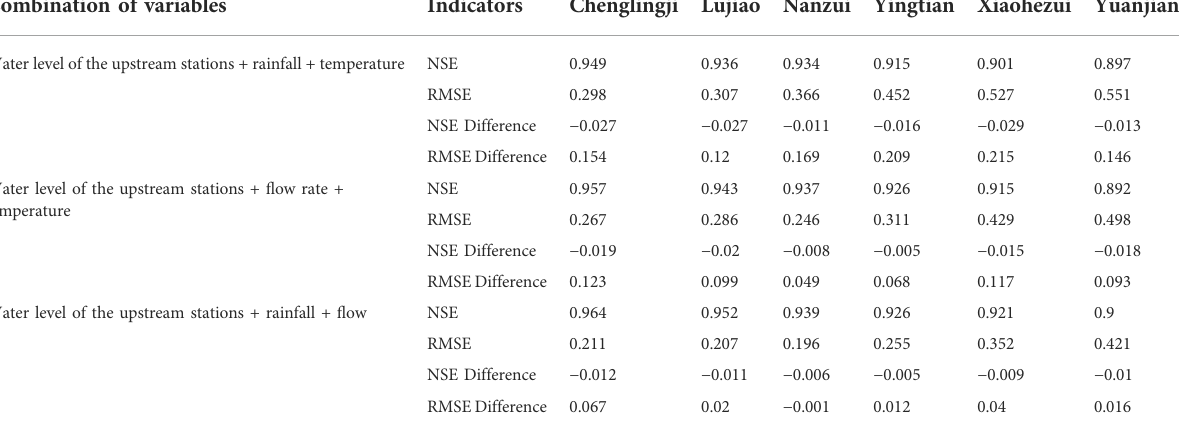
TABLE 3 Sensitivity analysis on the PSO-ENN